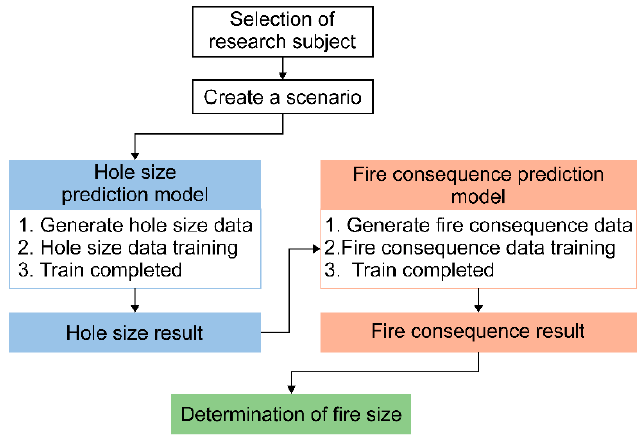
Figure 2. Research